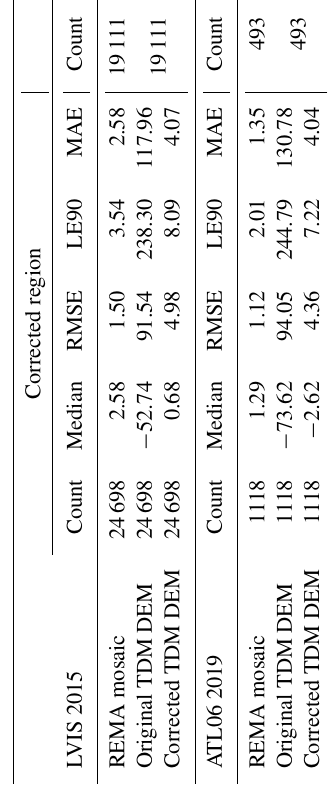
Figure 9. Elevation profiles along the black line extracted from the (a) original and (b) corrected TDM DEM of the local sample area.